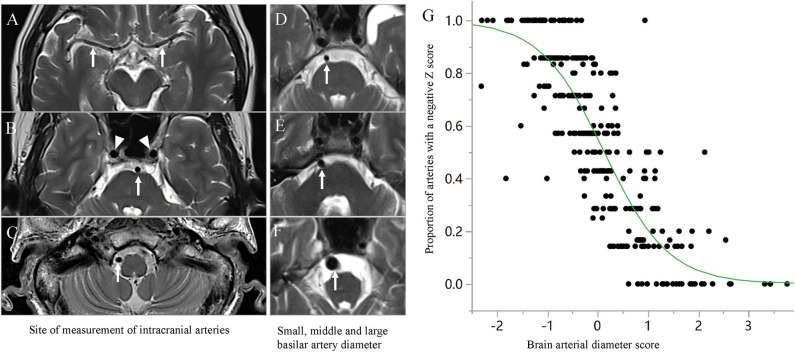
Spline regression fit for the proportion of arteries with a negative Z Score for lumen diameter. The diameters of main seven intracranial arteries were measured in the middle cerebral artery (R and L) at the M1 segment [(A), arrow], the basilar artery at the mid-pons [(B), arrow], the intracranial vertebral arteries (R and L) at the V4 segment [(C), arrow], and the internal carotid arteries (R and L) at the intracavernous segment [(B), arrowhead]. (D–F) show the small, middle, and large basilar arteries, respectively (arrow). The BAR score is a construct that discloses the tendency of an individual to have small or large arteries in a single number. As the score decreases, the proportion of arteries with small lumina increases and vice versa (G).